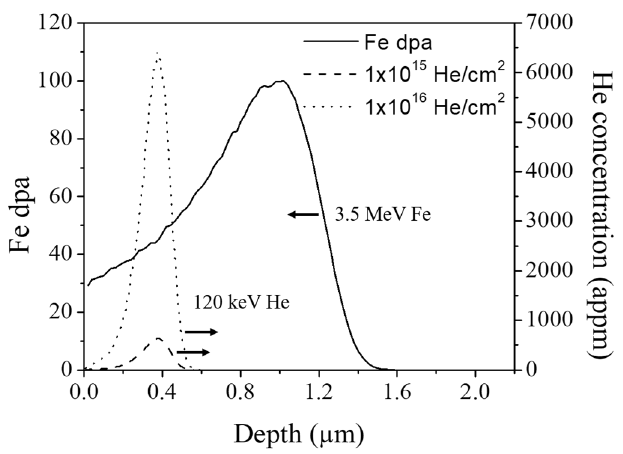
Figure 2. Stopping and Range of Ions in Matter (SRIM) calculations of damage profiles resulting from 3.5 MeV Fe ion irradiation and the He distributions resulting from 120 keV He ion implantation.